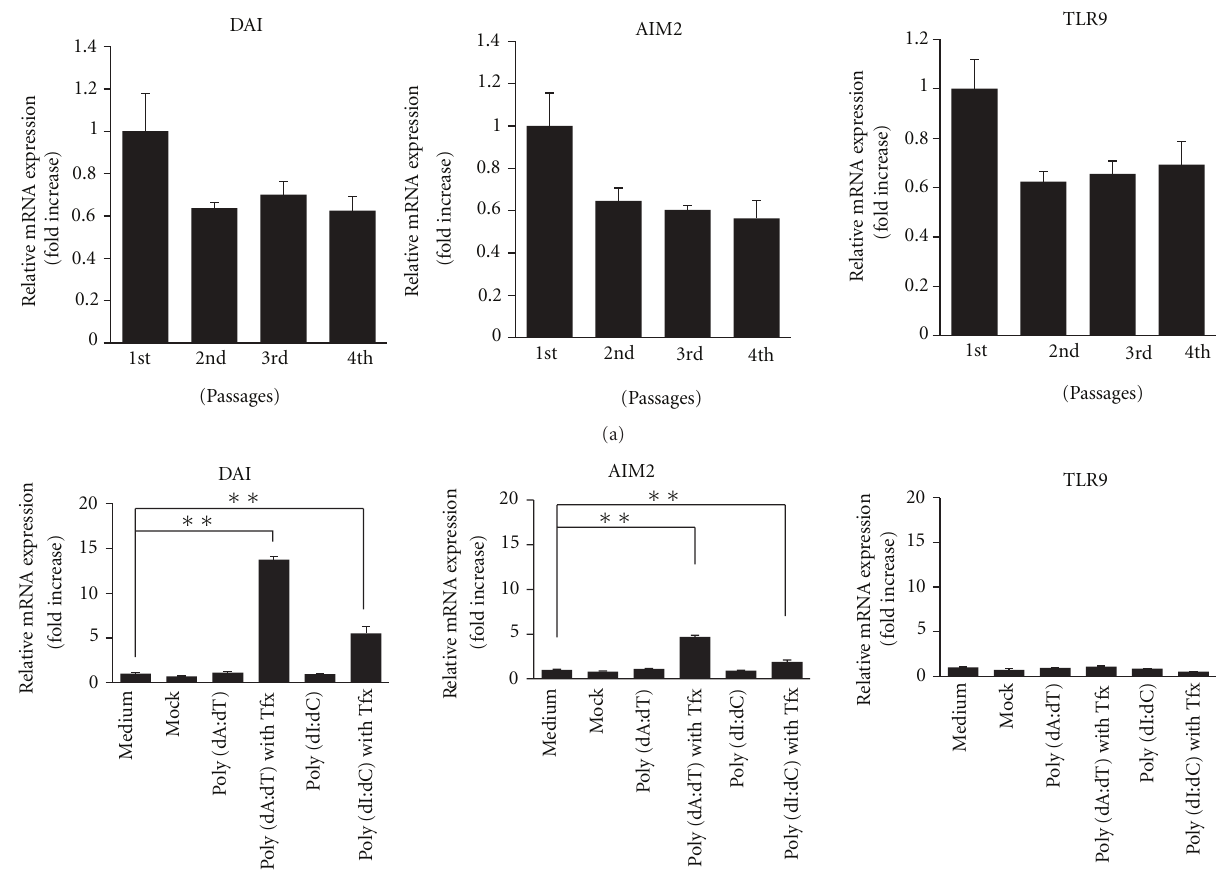
(b) Figure 1: (a) Pancreatic stellate cells (PSCs) expressed double-stranded DNA (dsDNA) receptors. Total RNA was prepared from freshly isolated (3 days after isolation) culture-activated PSCs (passages 2 and 4). Expression of the dsDNA receptors was assessed by real-time PCR. All PSCs constitutively expressed DNA-dependent activator of IFN-regulatory factors (DAI), absent in melanoma 2 (AIM2), and toll-like receptor 9 (TLR9). (b) Extracellular DNA stimulation had no e ff ect on DNA receptors, such as DAI and AIM2. In contrast, intracellular dsDNA increased the expression of all dsDNA receptors except TLR9. PSCs: pancreatic stellate cells, TFx: + transfection reagent lipofectamine. ∗ P < 0 . 05, ∗∗ P < 0 .